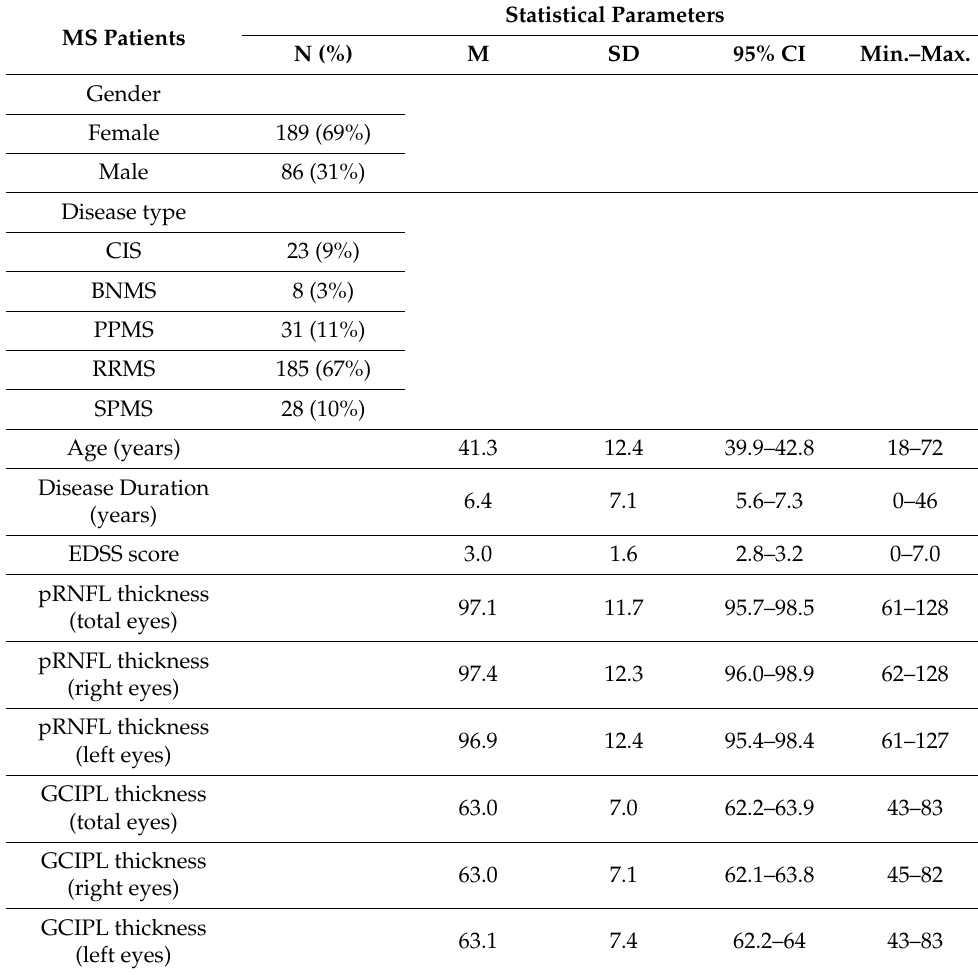
Table 1. Baseline